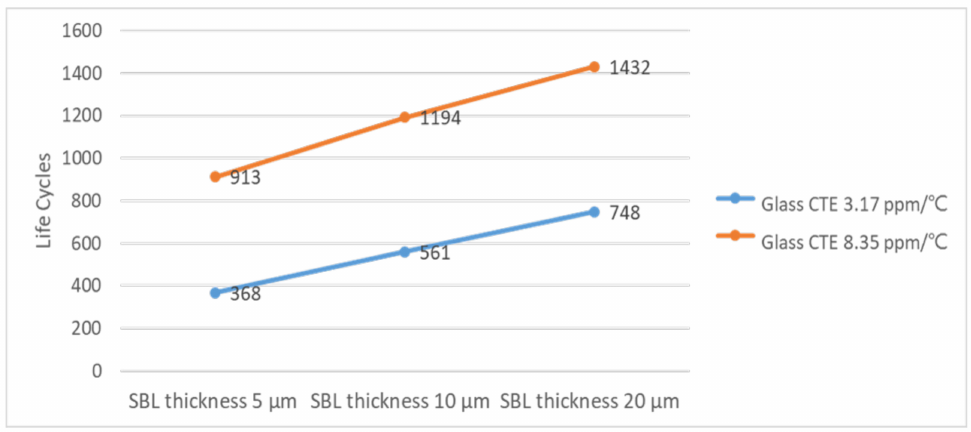
Figure 13. Simulated reliability life for stress buffer layers of different